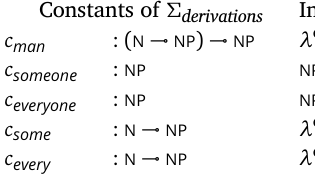
Interpretation of (cid:6) derivations constants by G derived trees